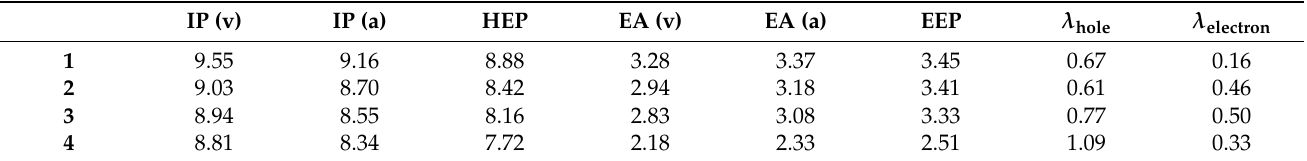
Table 3. IPs, EAs, extraction potentials, and reorganization energies for complexes (unit in